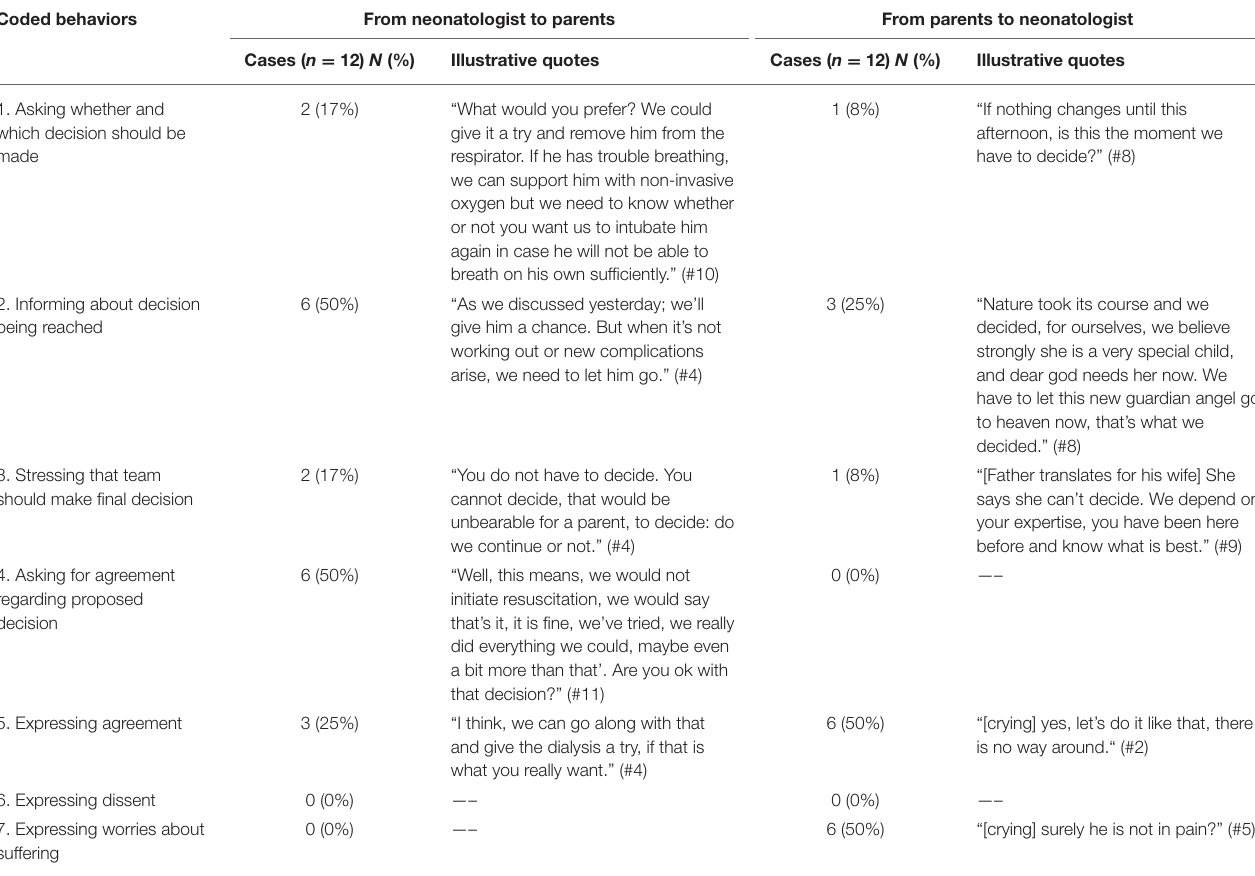
TABLE 5 | Stage 3: reaching a decision. Coded